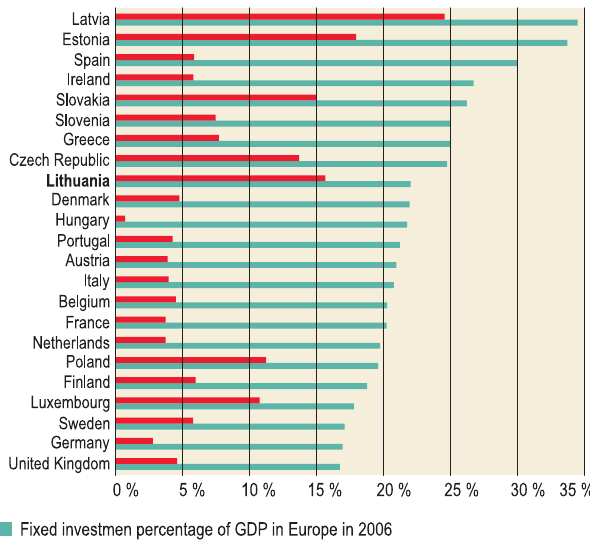
Fig. 1. Fixed investment percentage of GDP and GDP per capita growth in Europe in 2006; source: EUROSTAT (juxtaposed by authors)